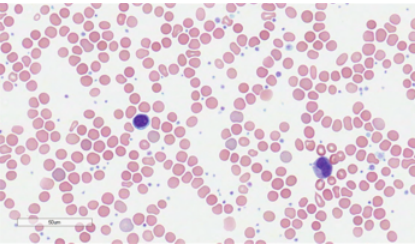
Figure 2: Peripheral smear showing leukoerythroblastosis and thrombocytosis.